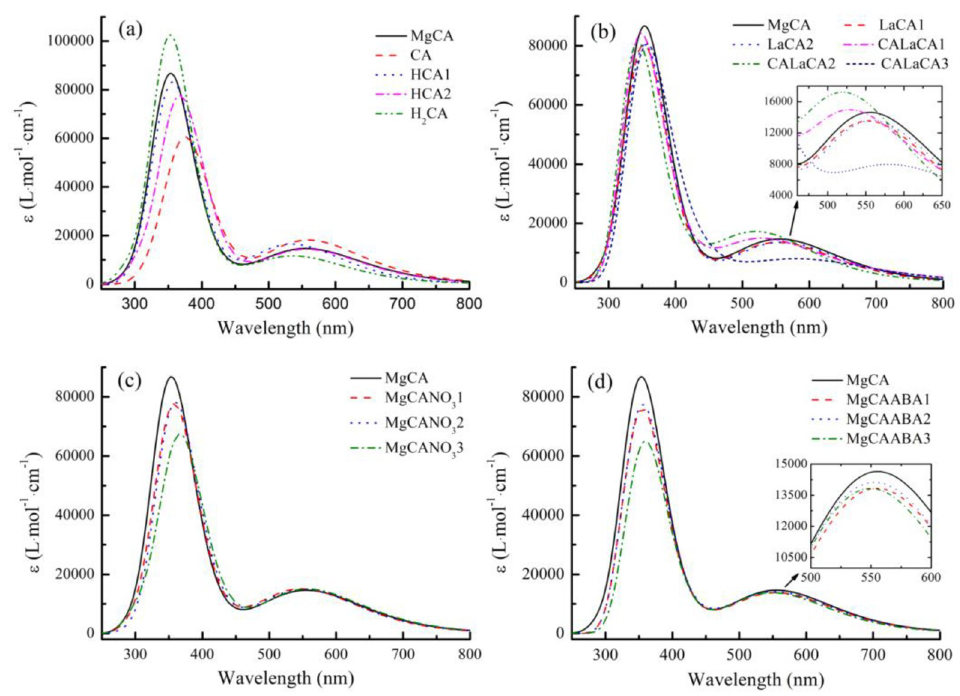
Fig 6. Simulated electronic absorption spectra of different compounds in ethanol. (a) MgCA, CA, HCA1, HCA2, and H 2 CA; (b) MgCA, LaCA1, LaCA2, CALaCA1, CALaCA2, and CALaCA3; (c) MgCA, MgCANO 3 1, MgCANO 3 2, and MgCANO 3 3; (d) MgCA, MgCAABA1, MgCAABA2, and MgCAABA3.